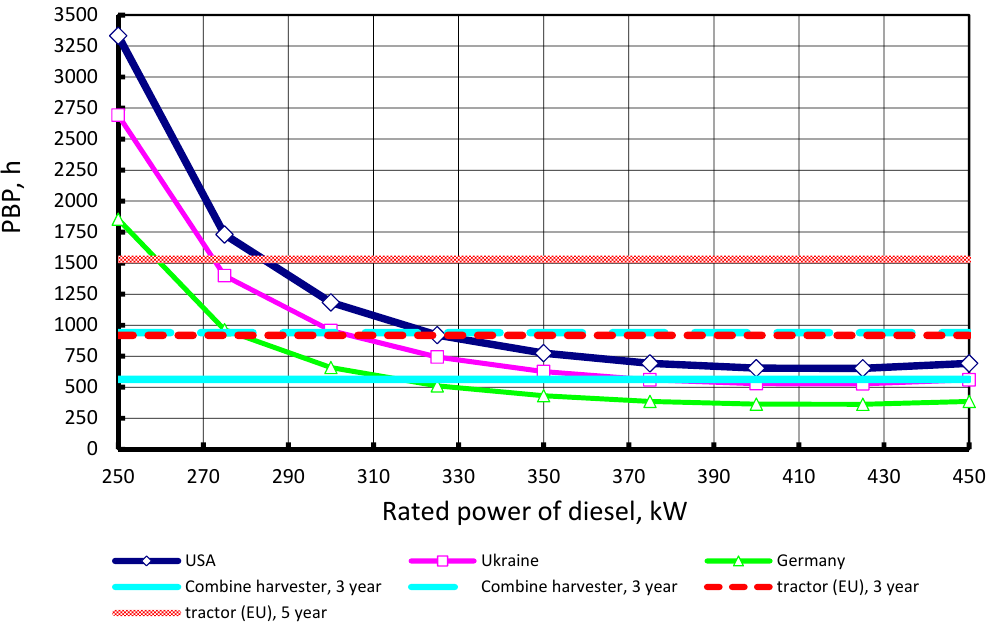
Figure 4. Simple payback period (PBP) for turbocompound system. Source: developed by authors.